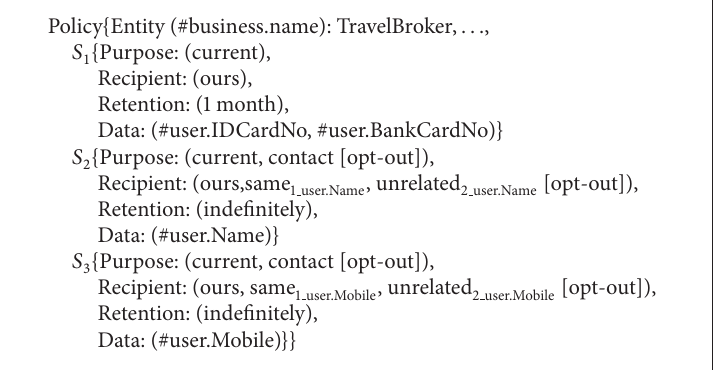
Algorithm 10: P3P privacy policy for